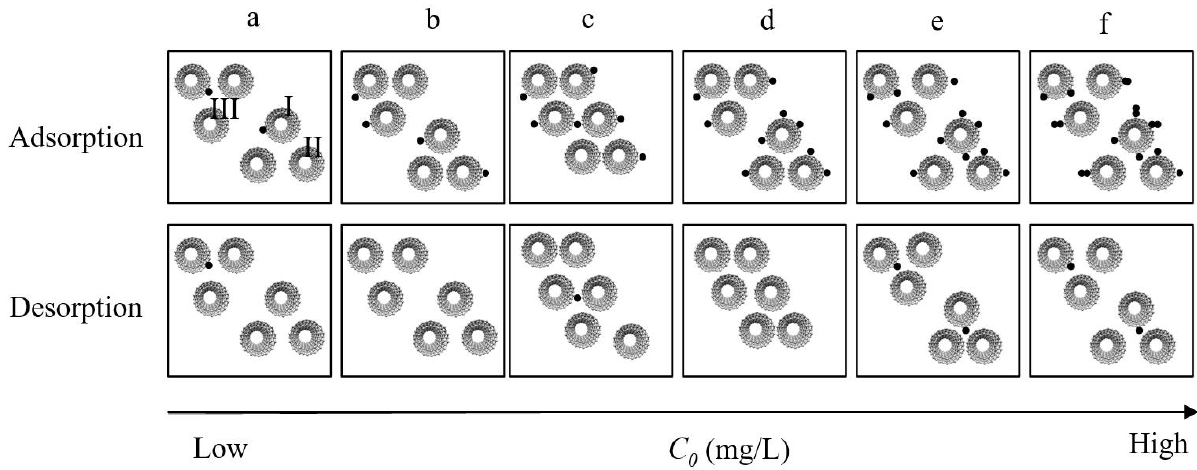
Figure 3. Schematic diagrams for the adsorption − desorption of nitrobenzene on CNTs. The letters I, II, and III indicate the possible adsorption area of the surface, groove, and interstitial spaces, respectively. The lowercase letters “a, b, c, d, e, f” represent the beginning or end of five stages of adsorption-desorption hysteresis of nitrobenzene on MWCNTs: more reversible ( a , b ) — more irreversible ( b , c ) — more reversible ( c , d ) — more irreversible ( d , e ) — more reversible ( e , f ). C 0 is the initial concentration of nitrobenzene.